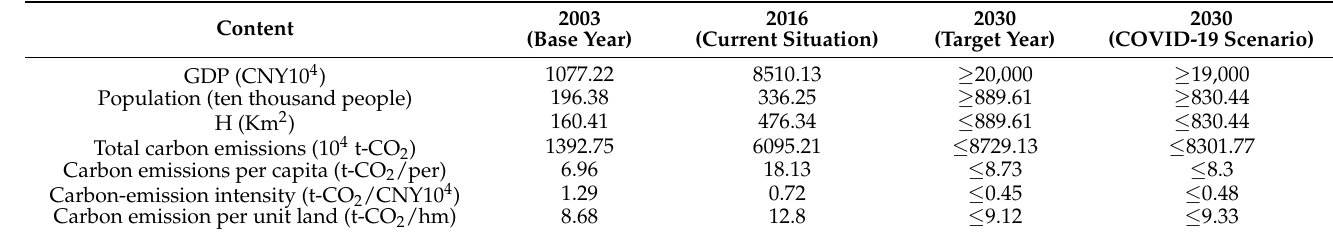
Table 8. The CO 2 constraint value of Changsha city in